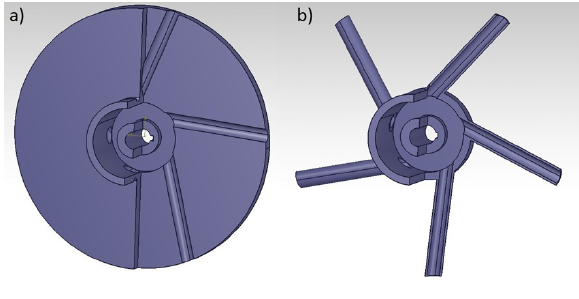
Figure 1: Comparison of geometry of rotors of special centrifugal pumps: a) hole impeller, b) multi-piped